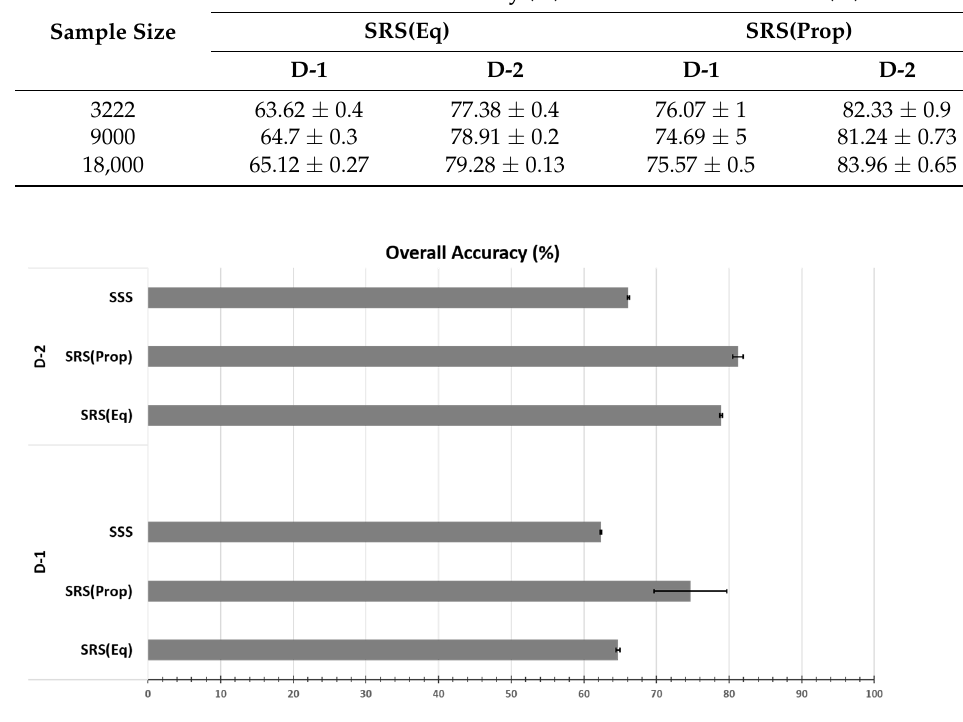
Figure 5. Average overall accuracy values of RF classified land cover map obtained for different sampling methods and datasets D-1 and D-2. The overall sample size for SRS(Eq) and SRS(Prop) are taken as 9000, while that for SSS is taken as 8460. The error bars indicate the standard deviation of overall accuracy for 100 trials.